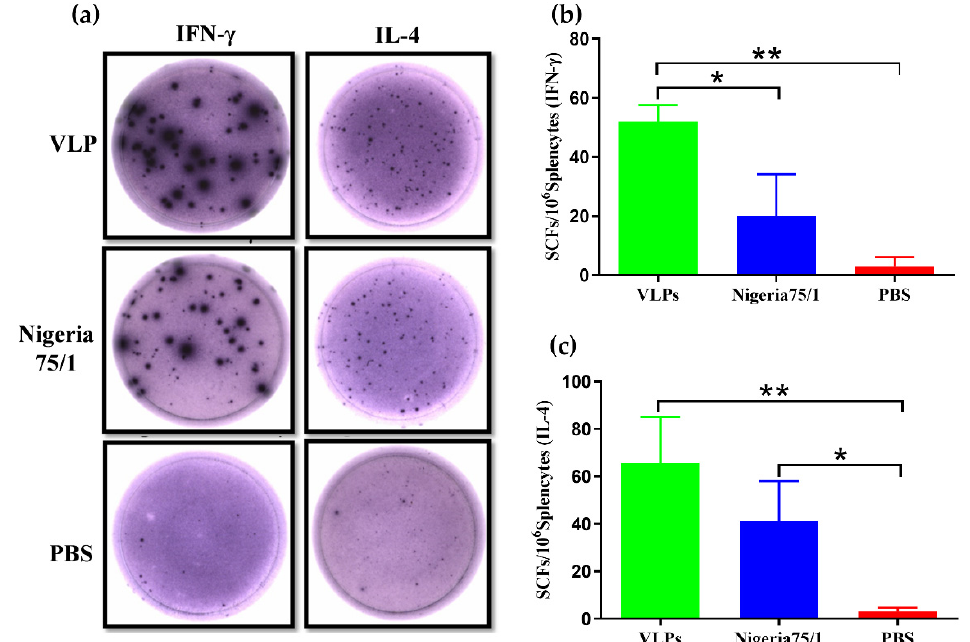
Figure 3. Immunization induces a cell-mediated immune response in mice. Splenocytes from mice were stimulated with inactivated PPRV two weeks after the second immunization. ( a ) Representative images of IFN- γ - and IL-4-secreting splenocytes. ( b,c ) ELISpot assay was used to enumerate IFN- γ - secreting (b) or IL-4-secreting (c) splenocytes. Data are depicted as the mean ± SD spot-forming cells